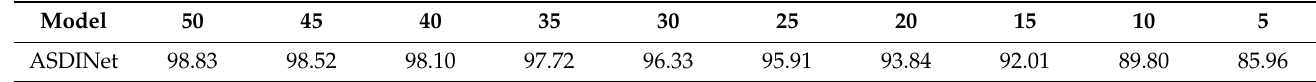
Table 9. The performance of the ASDINet trained between 50 and 5 defective images.